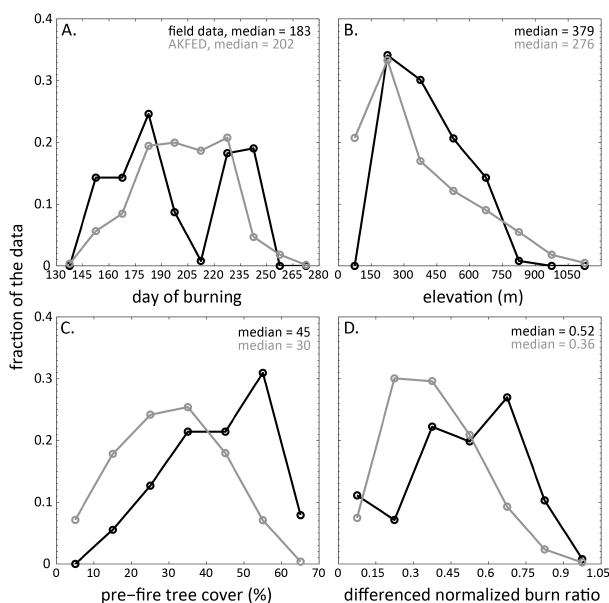
Figure 11. Attribution of uncertainty sources in (a) belowground, (b) aboveground and (c) total carbon consumption estimates. The standard deviation of the consumption estimates from 1000 Monte Carlo simulations was calculated for each